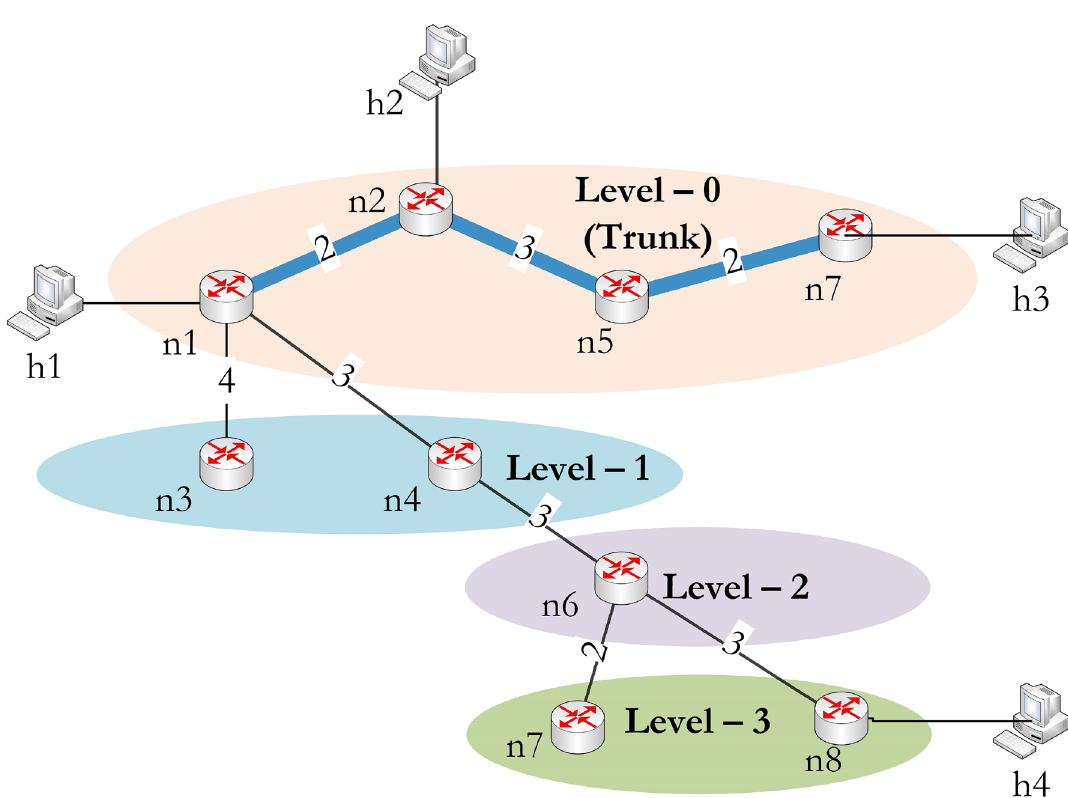
Figure 3. Level formation based on shortest path